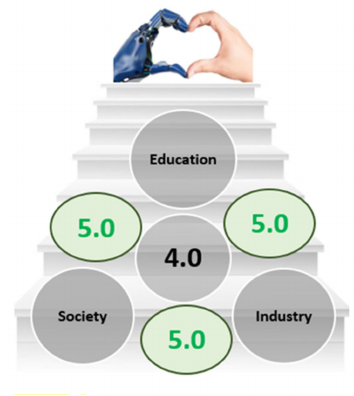
Figure 1. On the way to the new